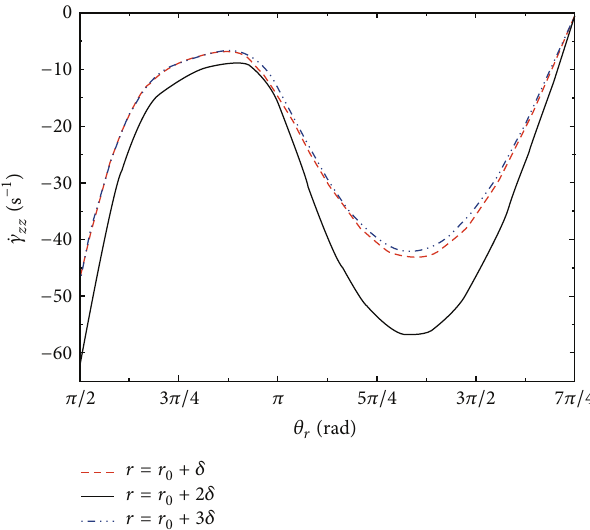
Figure 4: The axial tensile strain rate of melt moving in a chamber of VCPU: feed process.